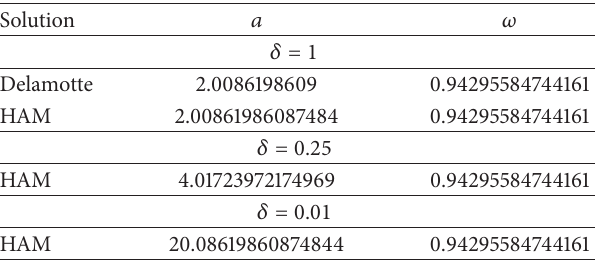
Table 1: The frequency and amplitude of the van der Pol equation with 𝜀 = 1 , by Delamotte’s and 100th-order HAM solution, respec-